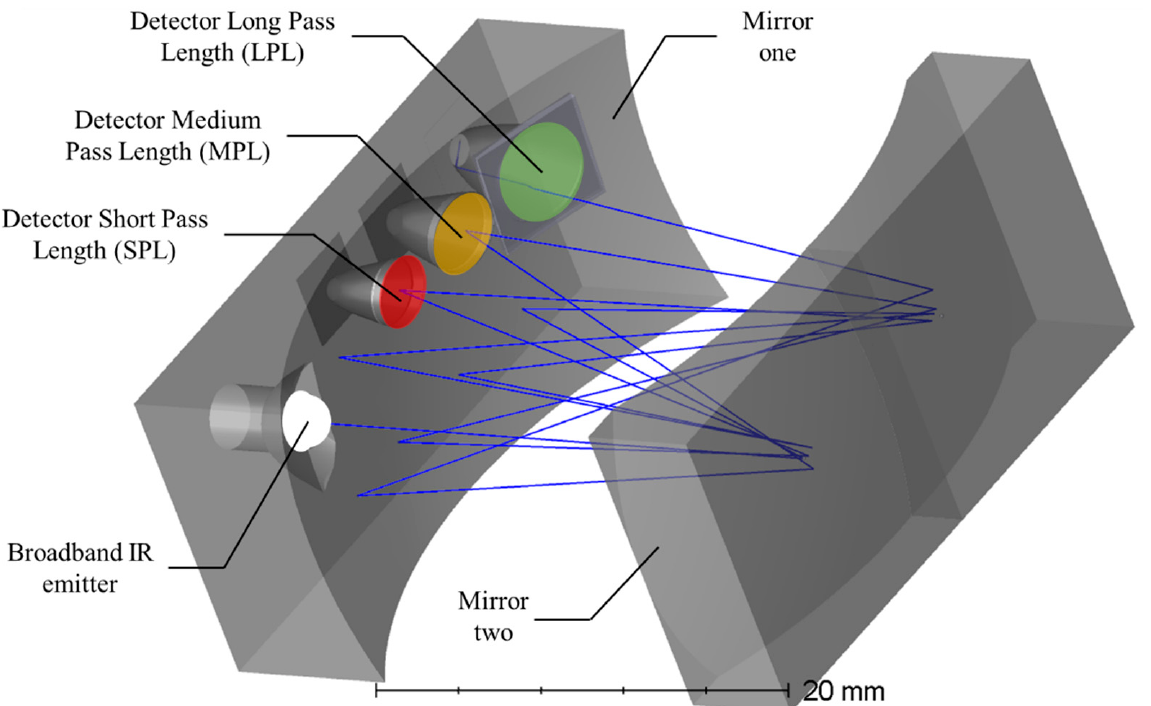
Figure 2. Schematic illustration of the K96 sensor multi-gas sensing principle. The patented multi- spectral sensor fuses three individual NDIR White Cell configurations. The two opposing spherical mirrors define the length of the individual optical propagation paths. One of the mirrors houses the IR emitter and the three wavelength selective detectors.